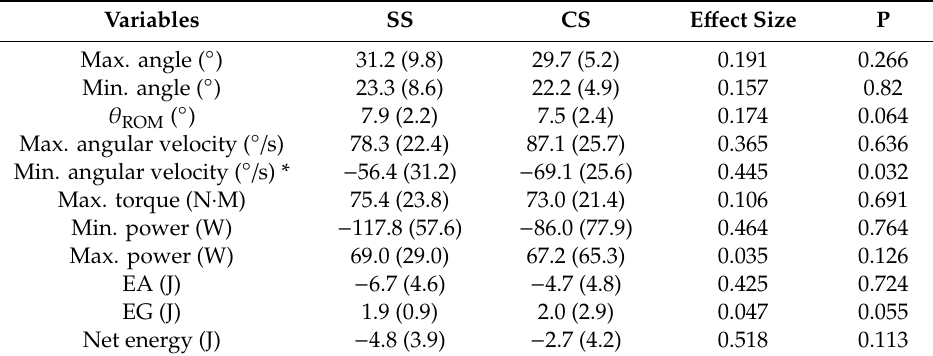
Table 2. MTP joint kinematics and kinetics during LJs (n = 30, Mean (SD)).